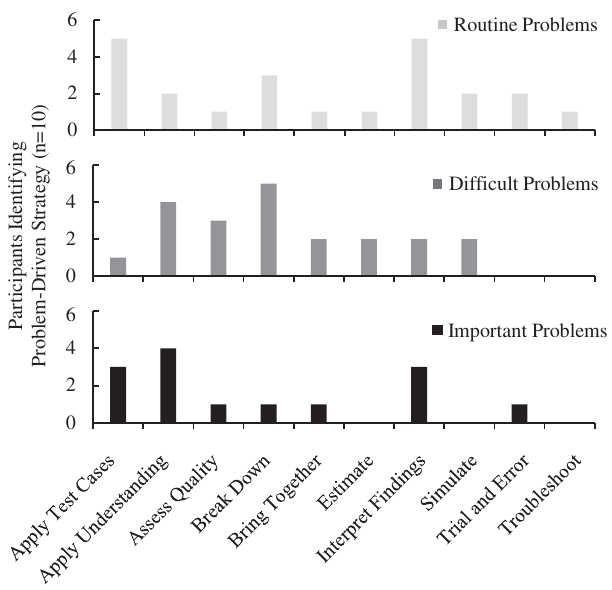
FIG. 5. Problem-driven strategies used to solve routine, diffi- cult, and important problems in Ph.D.-level